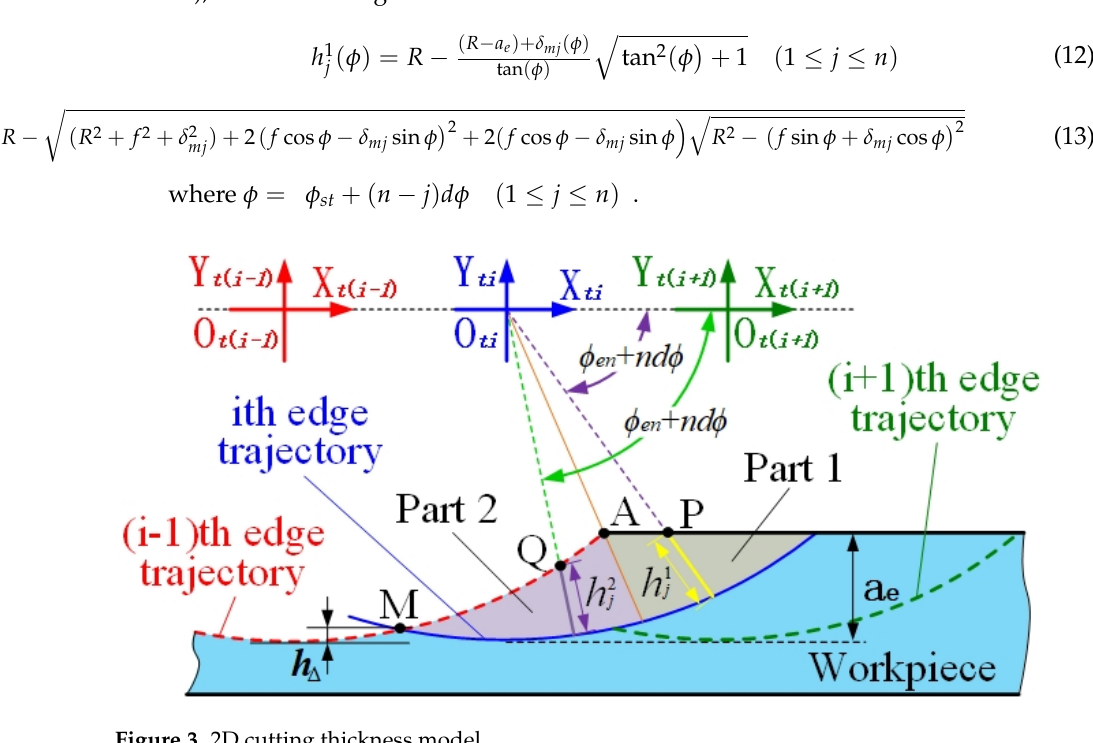
Figure 3. 2D cutting thickness model.